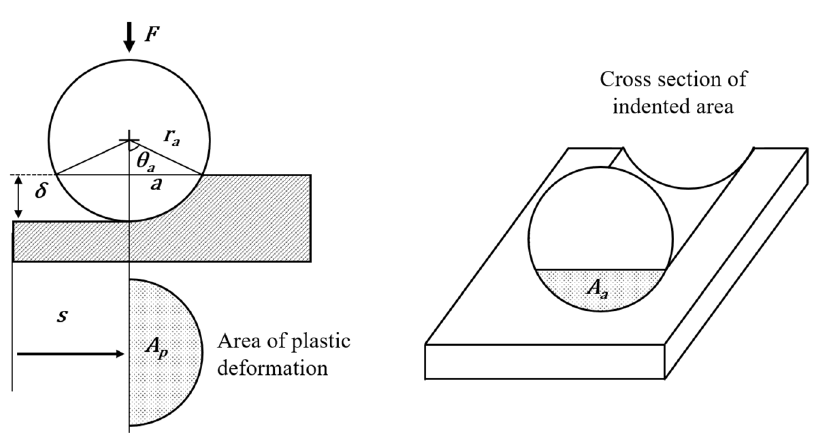
Figure 3. Abrasive indentation model.